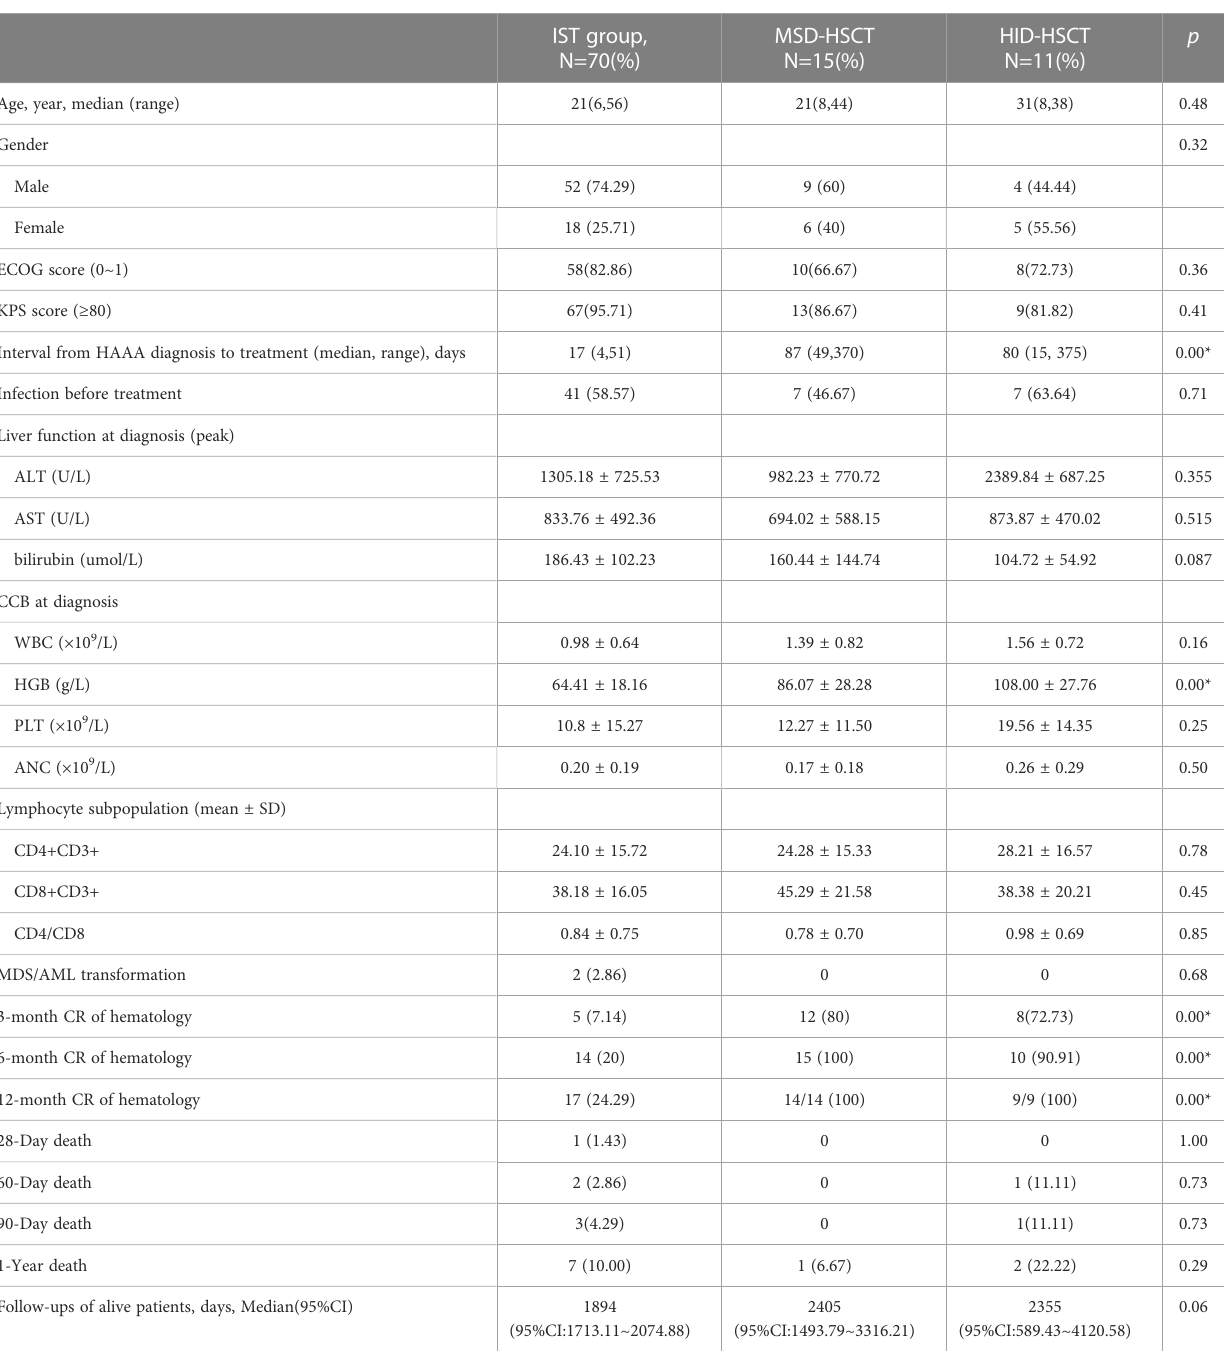
TABLE 1 Basic characteristics of HAAA